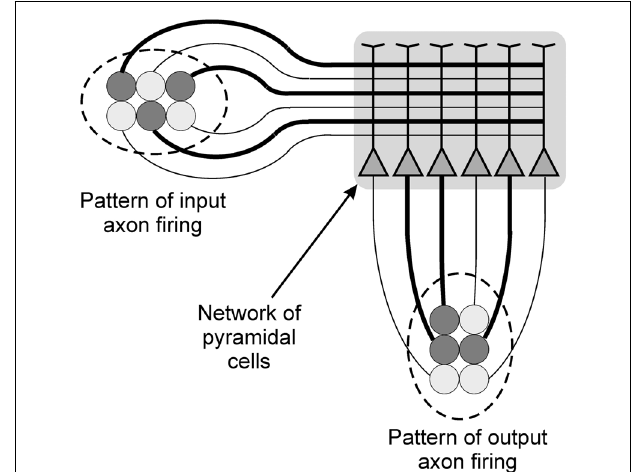
FIGURE 1 | Diagram showing the feed-forward sweep and re-entrant feedback of information felt to be necessary for conscious percepts. The conscious percept itself could arise in some way from local activity in the sensory cortex stimulated by the re-entrant feedback, as indicated by the star.